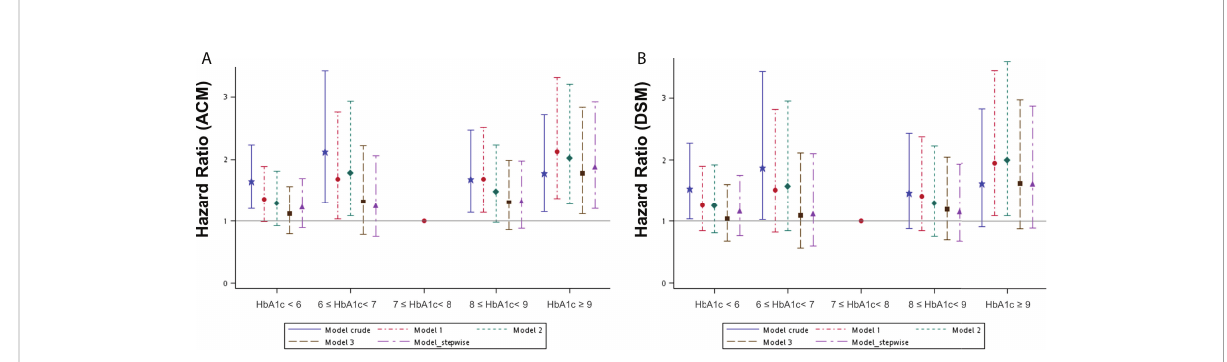
FIGURE 3 Hazard ratios for mortality events according to the different mean HbA1c intervals during the whole study period in patients with diabetes mellitus by several models. (A) ACM, all-cause mortality; (B) DSM, disease-speci fi c mortality. Model 1 was adjusted for age, sex, tumor site, and clinical AJCC stages of cancer. Model 2 was adjusted for the variables in model 1 plus BMI, lifestyle risk factors, and treatment. Model 3 was adjusted for the variables in model 2 plus comorbidities and medication use. Model 4_ stepwise was built with variables according to the statistical software (a stepwise solution).